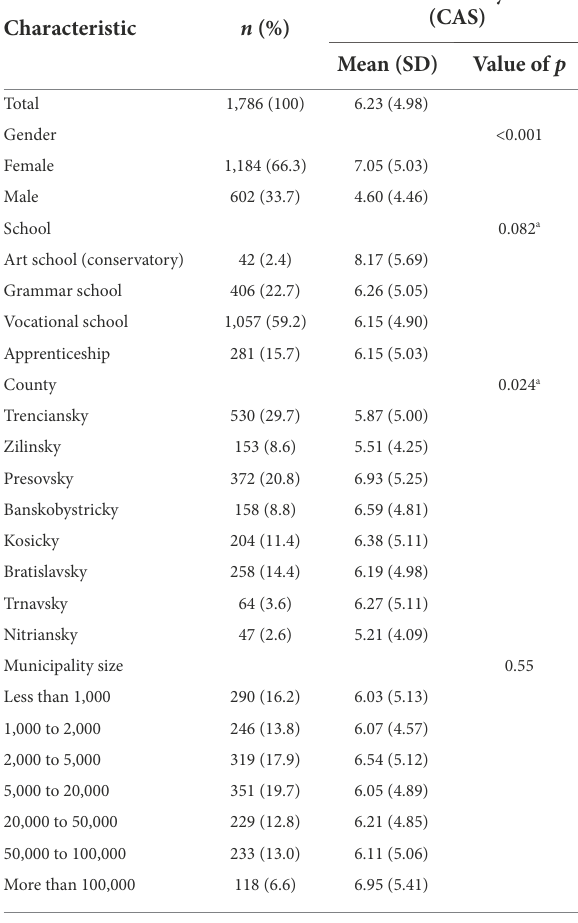
TABLE 2 Descriptive characteristics of the data, comparison of COVID anxiety between sociodemographic groups.